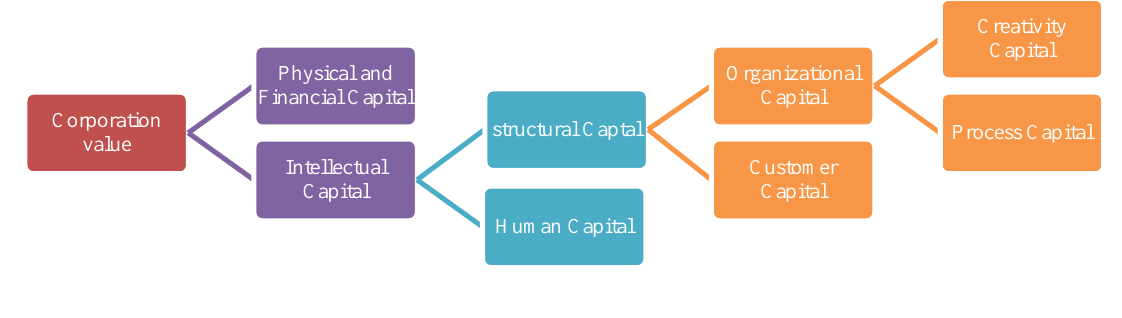
Fig 1 . Traditional model of intellectual